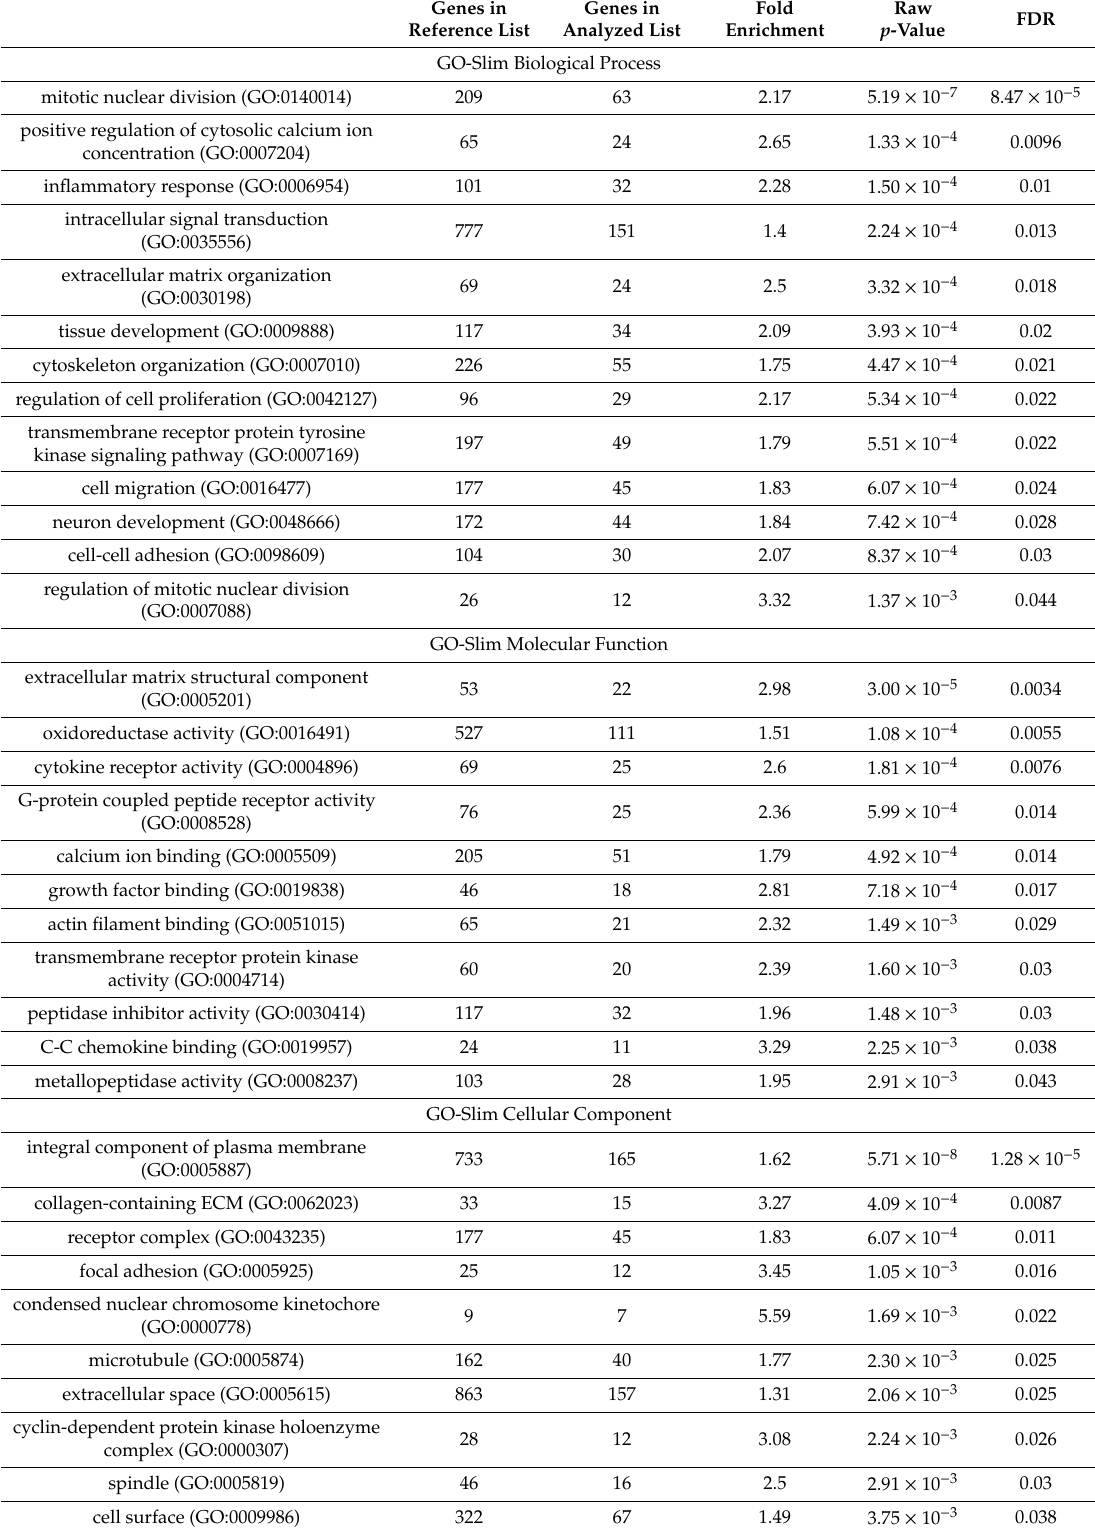
Table 5. Overrepresented GO-Slim terms among DE genes in SCB. The reference list is Homo sapiens UniProt IDs and includes 20996 genes; the analyzed list is comprised of the UniProt IDs for 2923 DE genes identified from SCB samples. FDR = false discovery rate (significance set at 0.05). A complete hierarchical list of overrepresented terms can be found in Table